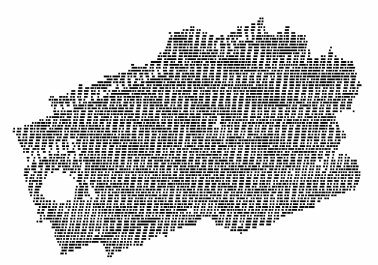
Figure 3: Points of the top of the tower are missing in the original point cloud of market church.